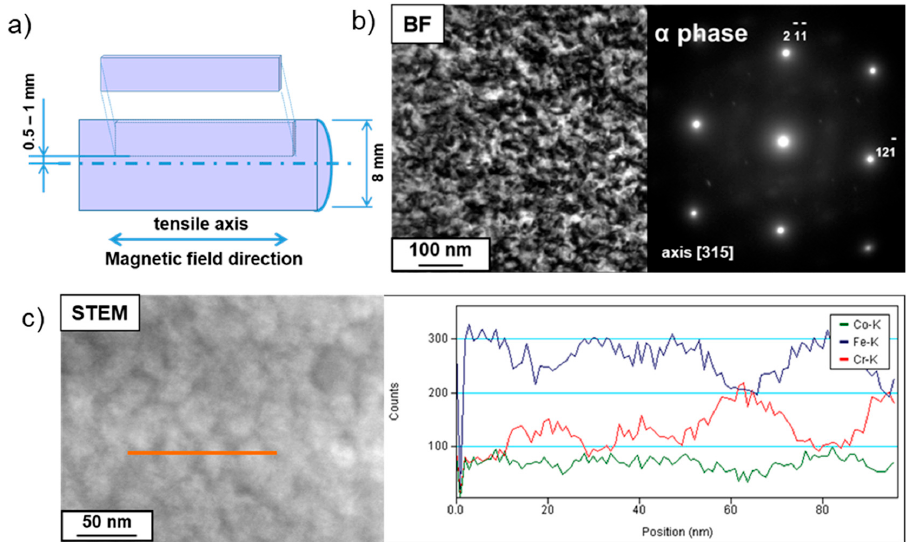
Figure 4. Scheme of the sample cutting for magnetic treatment ( a ). Bright field image and diffraction of the microstructure obtained from the surface layer of the sample deformed at 800 °C after magnetic treatment ( b ), TEM. STEM image of the same microstructure and distribution of Co, Fe, and Cr along the line of analysis in image ( c ).